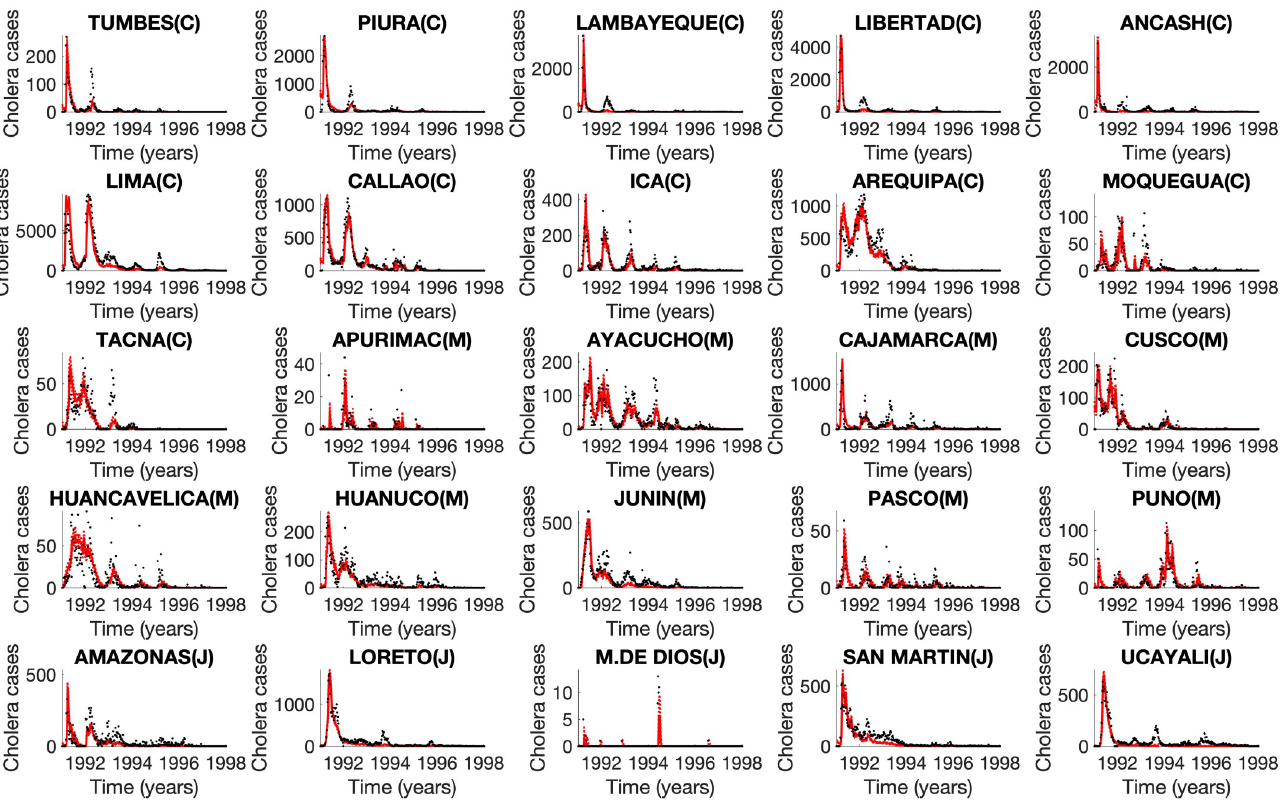
Fig 5. Mechanistic model fits to weekly cholera incidence across 25 departments in Peru, 1991-1997. The black dots correspond to the data, whereas the model mean fit is the red solid line and the dashed red lines correspond to the 95% prediction intervals.